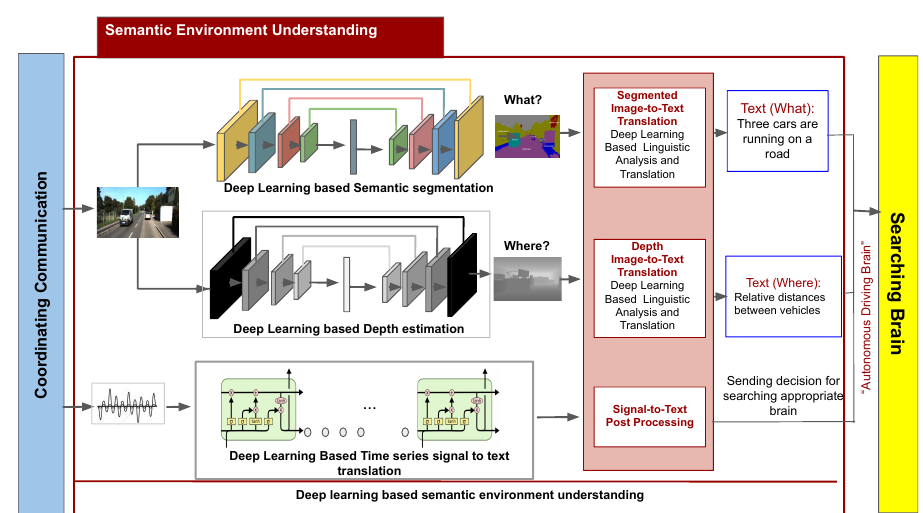
Figure 4. Semantic environment understanding.